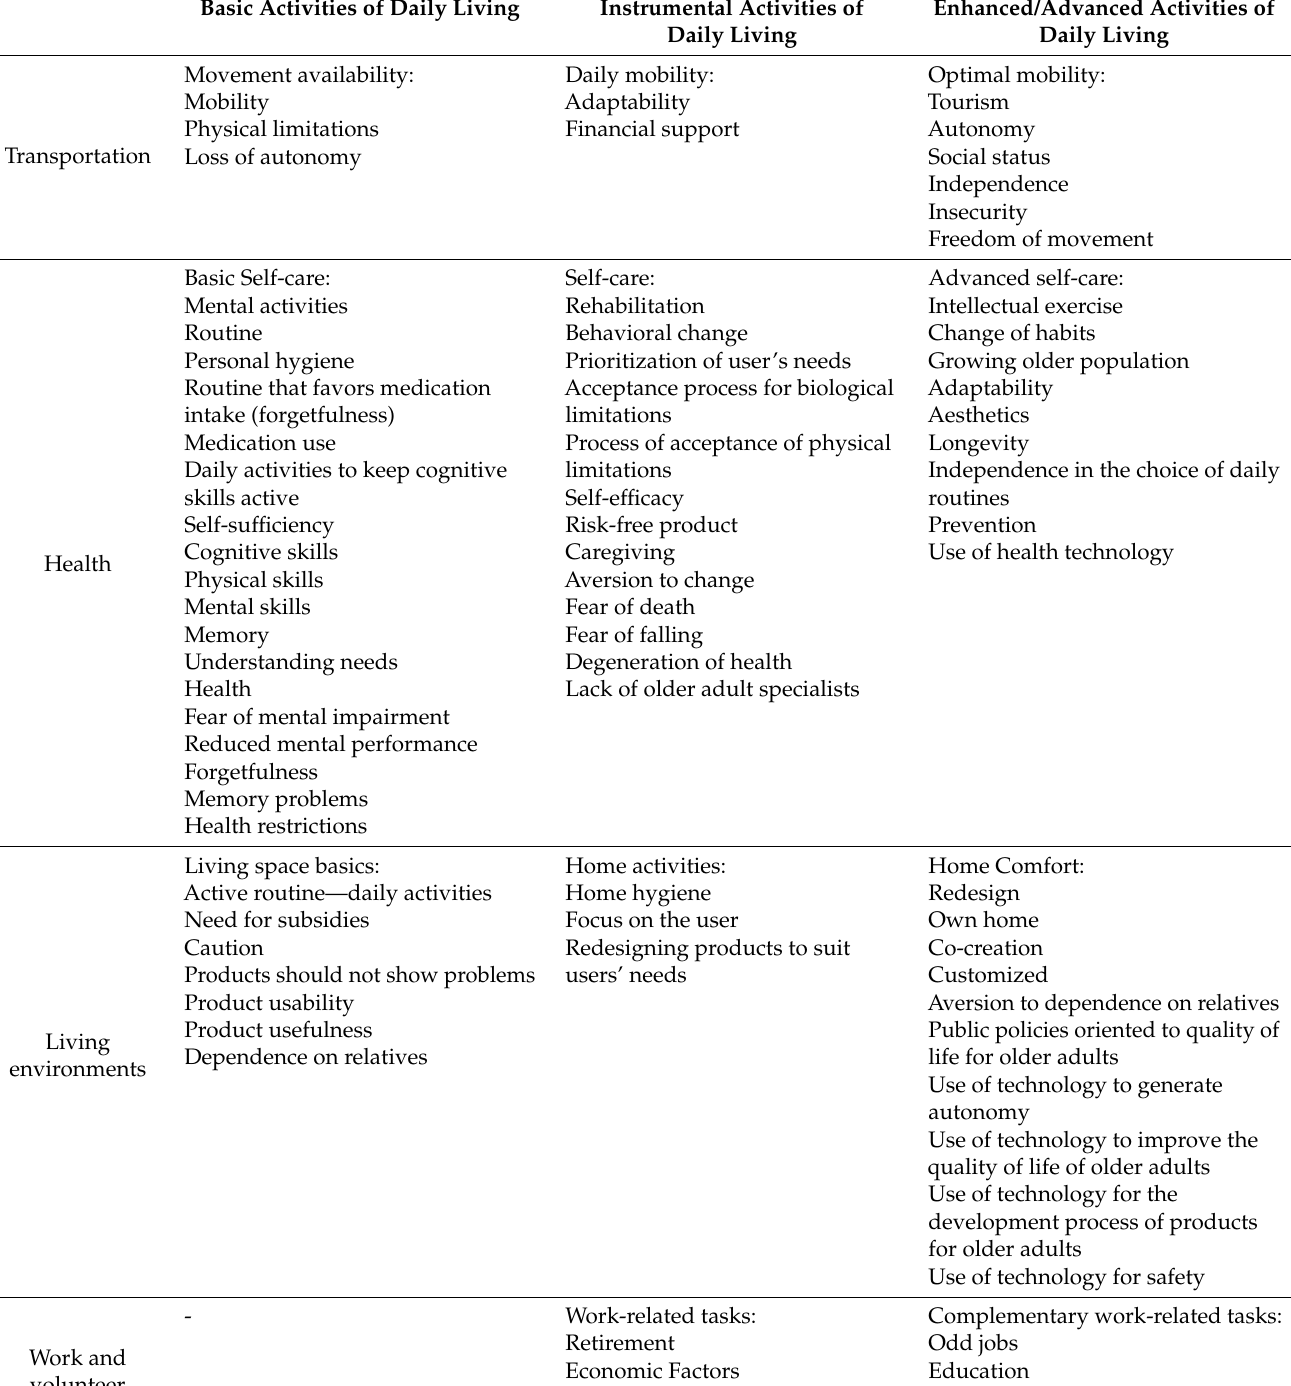
Table 4. Categorization of the concepts of needs and solutions using